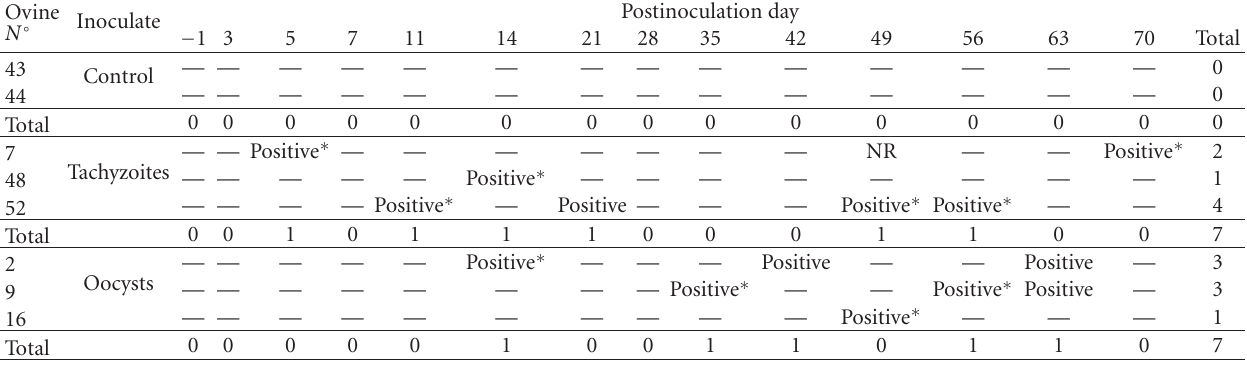
Table 3: Investigation of T. gondii in seminal samples of noninoculated (control) and T. gondii oocyst-inoculated (2 . 0 × 10 5 ) or tachyzoite- inoculated (1 . 0 × 10 6 ) animals.